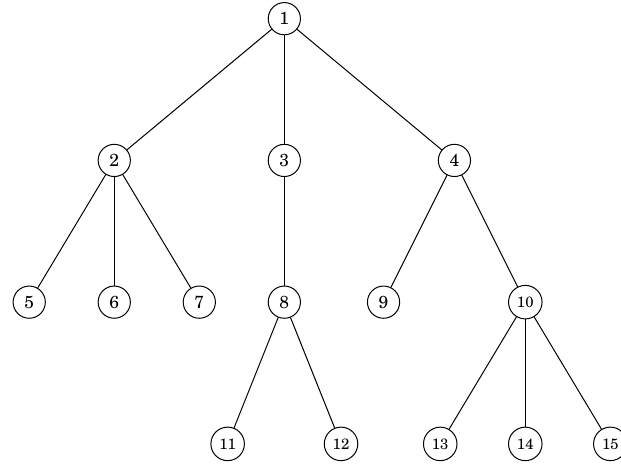
Figure 5: A productive labeling of a